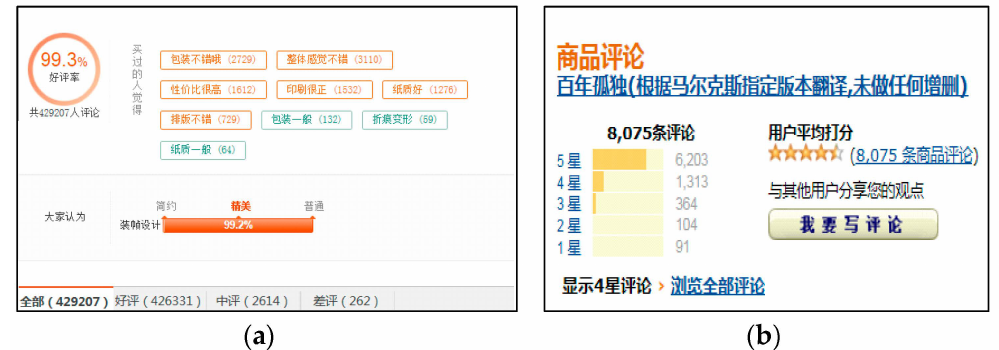
Figure 5. Evaluation interference of the same book on Dangdang and Amazon (Both in Chinese language). ( a ) Evaluation interference on Dangdang. ( b ) Evaluation interference on Amazon.